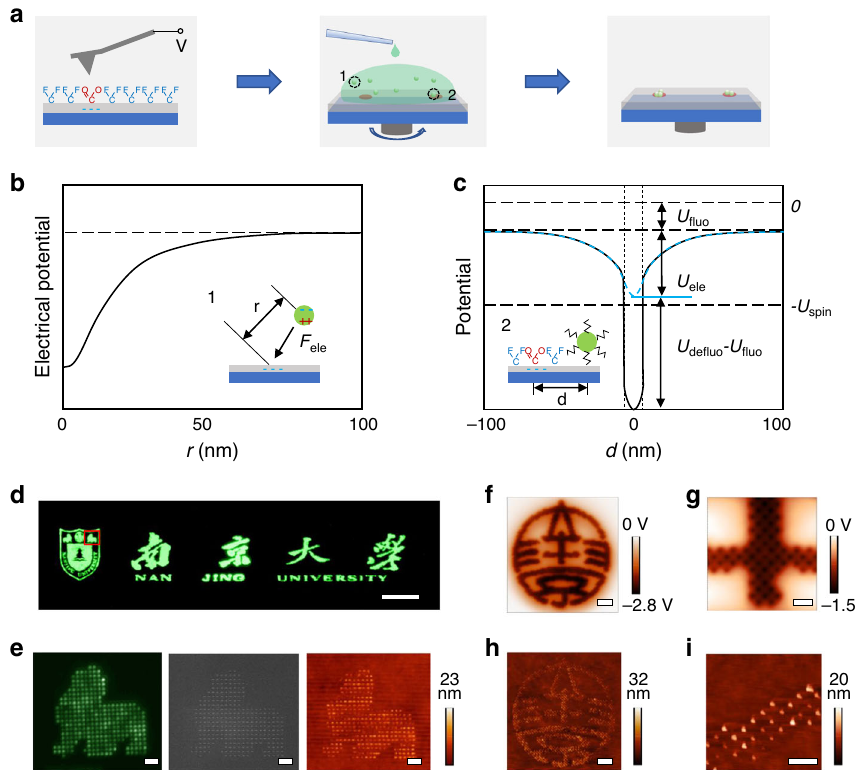
Fig. 1 Nanoprinting of perovskite QDs by EFASP. a Schematic illustration of the EFASP process, which involves high-voltage electrostatic nanopattern generation, surface modi fi cation, and site-speci fi c NP assembly by electrical trapping. b Electrical trapping potential in a nonpolar solvent as a function of the distance from the center of the written charge (dash circle 1 in a ). The electric fi elds can extend for hundreds of nanometers, leading to the high ef fi ciency of NP collection. c Surface potential modulation along the nanopattern surface (dash circle 2 in a ) De- fl uorination through high voltage induces signi fi cant surface energy modulation, providing strong short-range interactions to fi x the NPs. d A large-scale photoluminescence (PL) image obtained by assembling CsPbBr 3 NPs using the EFASP process, with a total area of 100 × 800 μ m 2 with 9481 pixels, a pitch of 800 nm, and approximately 4.7 × 10 5 10- nm CsPbBr 3 NPs. Scale bar, 50 μ m. e High-magni fi cation PL, SEM, and AFM height images of the marked area in d . Scale bar, 2 μ m. f – i Extremely high- resolution EFASP can be produced by modulating patterns, reaching a pitch of 200 nm (125,000 DPI). The high-magni fi cation KPFM potential map and corresponding AFM height map after NP assembly ( f and h , scale bar: 2 μ m) and their details ( g and i , scale bar: 500 nm). The corresponding large area PL image is shown in Supplementary Fig.